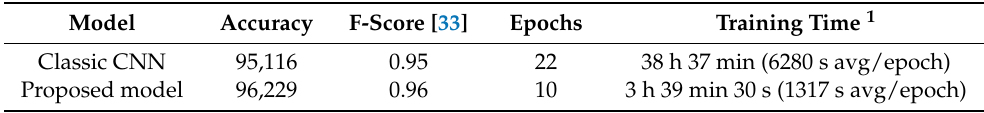
Table 2. Average benchmarking between the different executions.